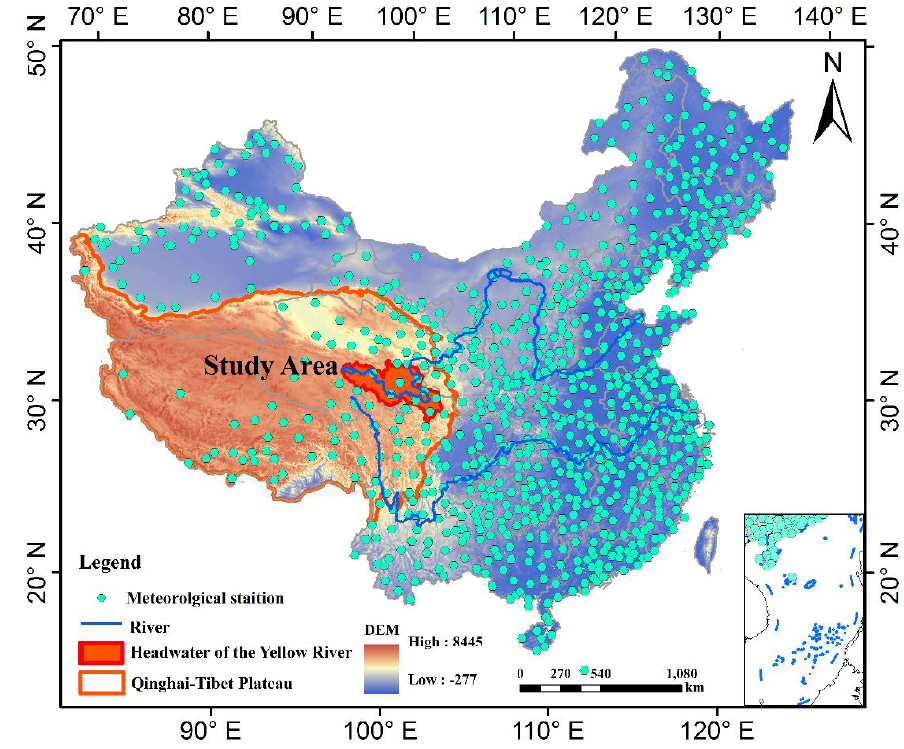
Figure A2. Weather station distribution map.